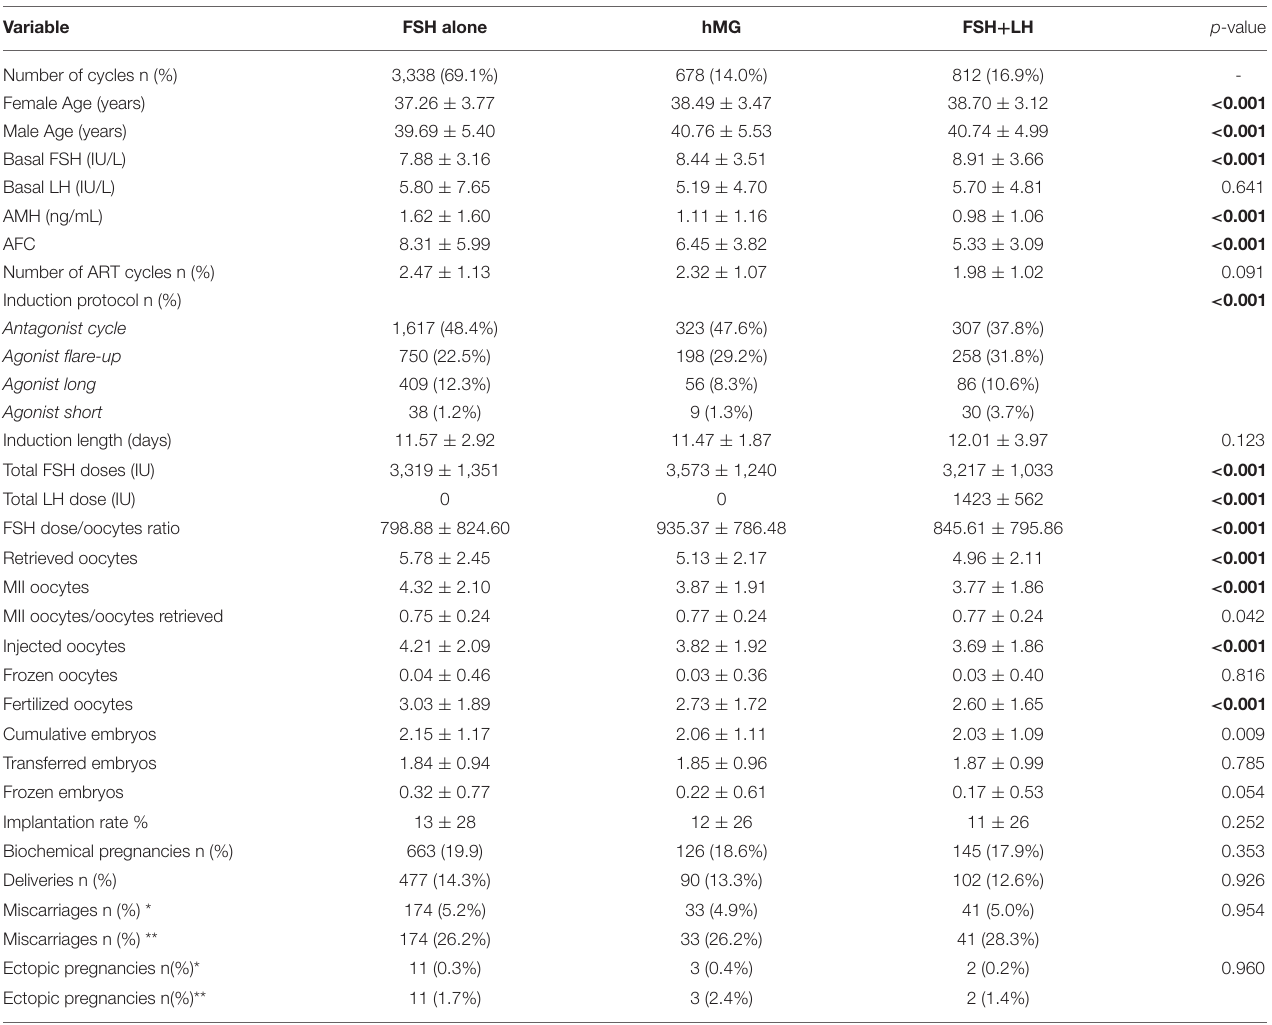
TABLE 1 | Patients and ART